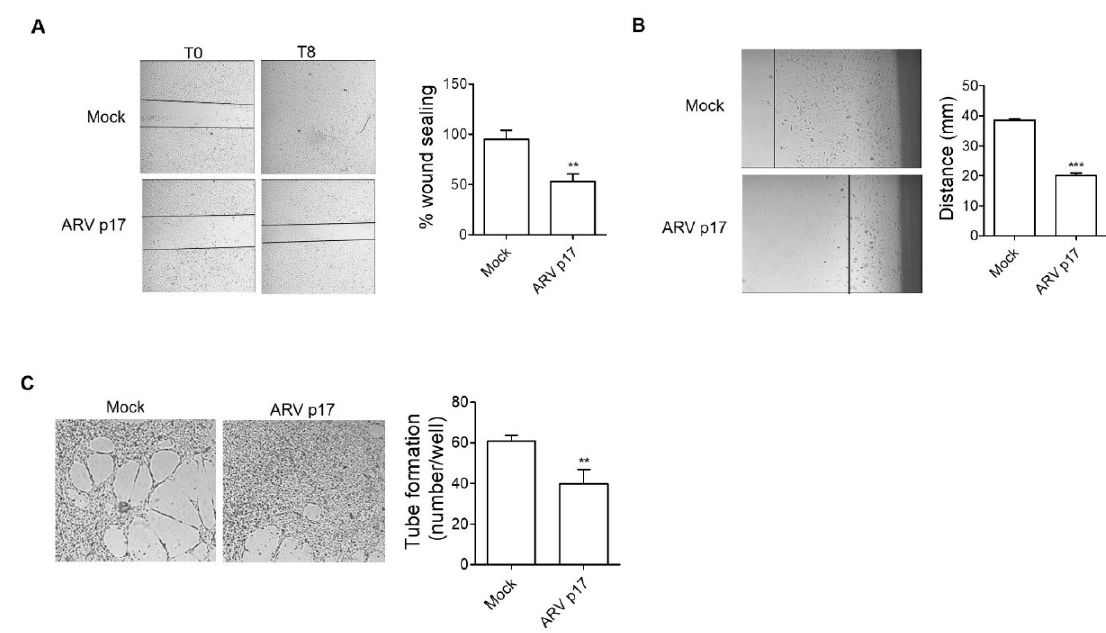
Figure 2. ARV p17 inhibits HUVEC cell migration and morphogenesis. HUVEC cells were mock-nucleofected (Mock) or nucleofected with ARV p17-expressing plasmid (ARV p17). ( A ) ECs’ wound repair ability was analyzed 48 h post- nucleofection. Confluent cell monolayers were scratched using a 200 µ L pipette tip and cell migration was recorded by light microscopy for 8 h after wound scratch (original magnification, 4 × ). The wound width was measured, and the relative wound area was calculated as the ratio of the remaining area at the 8 h time point to the 0 h starting point. Images are representative of one out of three independent experiments with similar results. Values are the mean ± SD of one representative experiment out of three with similar results, performed in triplicates. Statistical analysis was performed by Student’s t test. ** p < 0.01. ( B ) Cell movement along the bottom of an angled flask was recorded at day 10 post-nucleofection (original magnification, 10 × ). Cell motility rate was analyzed by measuring the distance from the edge of the flask to the leading edge of the cells. Images are representative of one out of three independent experiments with similar results. Values are the mean ± SD of one representative experiment out of three with similar results, performed in triplicates. Statistical analysis was performed by Student’s t test. *** p < 0.001. ( C ) HUVECs were seeded on BME-coated plates. Images were taken after 6 h of HUVEC culture on BME (original magnification, 4 × ). Closed rings were counted as a parameter for quantification of tube formation. Images are representative of one out of three independent experiments with similar results. Values are the mean ± SD of one representative experiment out of three with similar results, performed in triplicates. Statistical analysis was performed by Student’s t test. ** p <